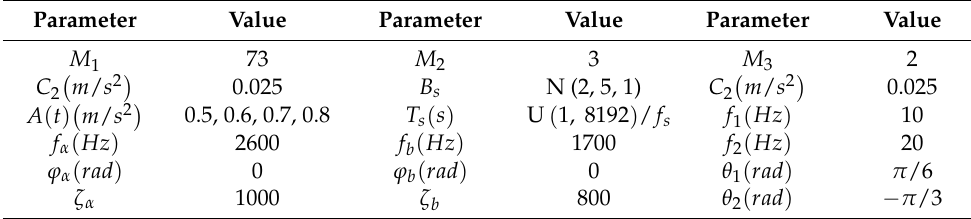
Table 2. Parameter values of bearing outer race fault simulation